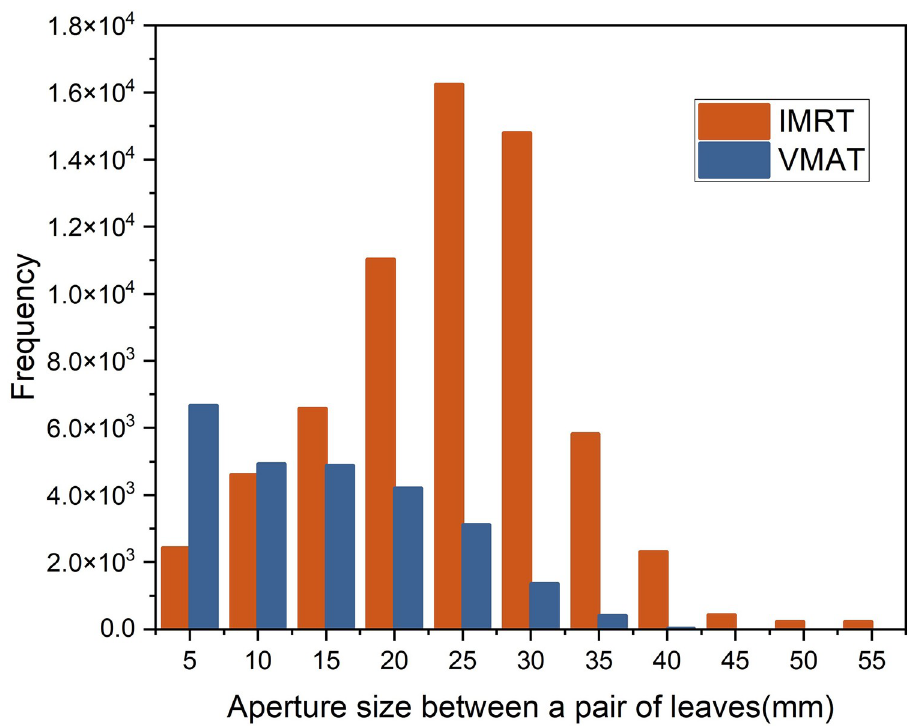
Fig 5. Frequency histogram of all windows formed by MLC leaf pairs during dynamic window delivery of all IMRT and VMAT plans.